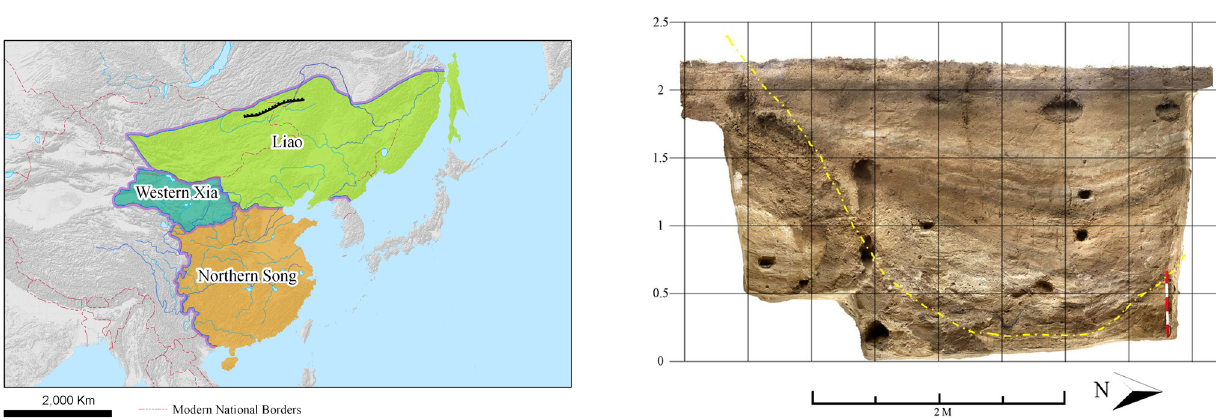
Fig. 3 Map of the Khitan-Liao Empire and other political powers of East Asia during the 11th century CE. The location of the “ Wall of Chinggis Khan ” is marked in black.